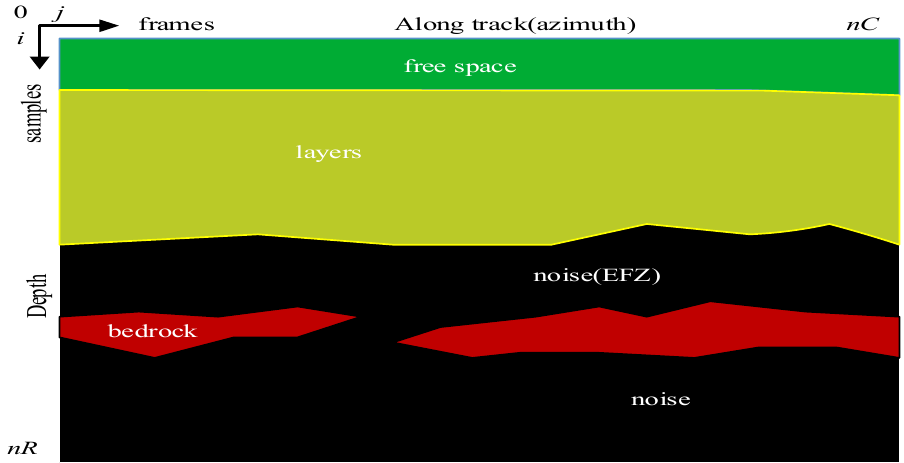
Figure 1. The typical radargram model includes free space, layers, echo-free zone (EFZ), bedrock, and noise.